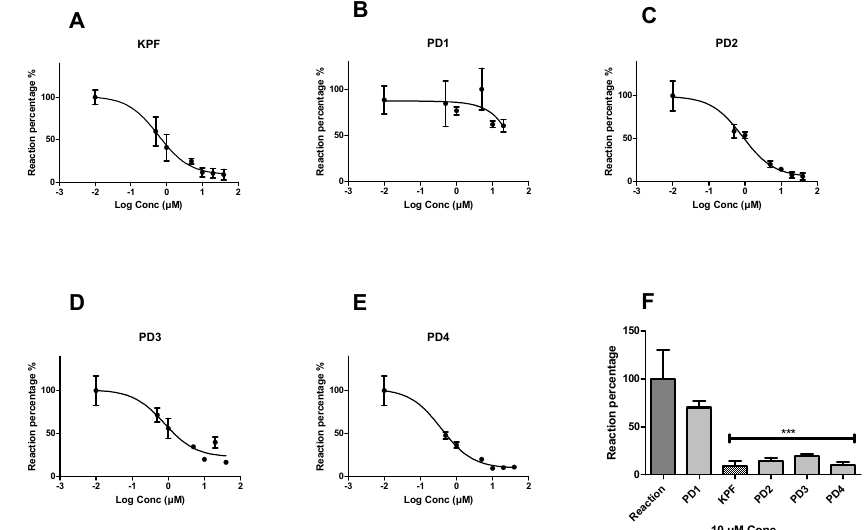
Figure 3. Dose-response curves showing the effect of different concentrations (0.5–40 µM) of the studied compounds on the peroxidase activity of COX. Fluorescence readouts after 30 min incubation time were plotted against the different concentrations of ketoprofen ( A ) PD1, ( B ) PD2, ( C ) PD3, ( D ) and PD4, ( E ) and a comparison of a single-concentration reaction (10 µM) is presented for all compounds ( F ) as a percentage from the reaction wells. Data are presented as mean ± SD ( n = 3). An asterisk denotes a significant difference from the reaction group (*** p < 0.0001, one-way ANOVA, followed by Dunnett’s test).